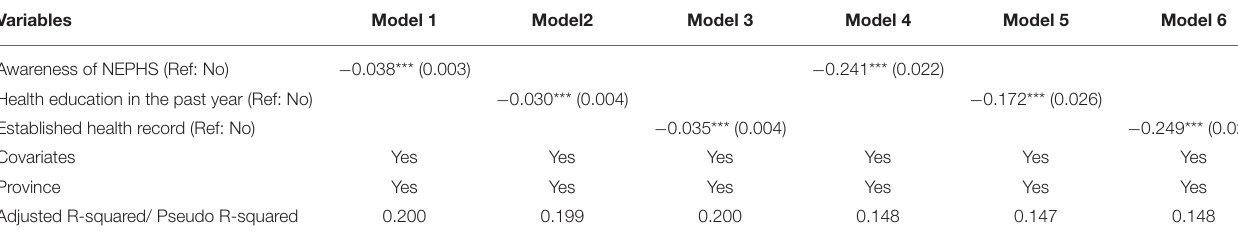
TABLE 3 | The impact of awareness and utilization of EPHS on health status of migrants.